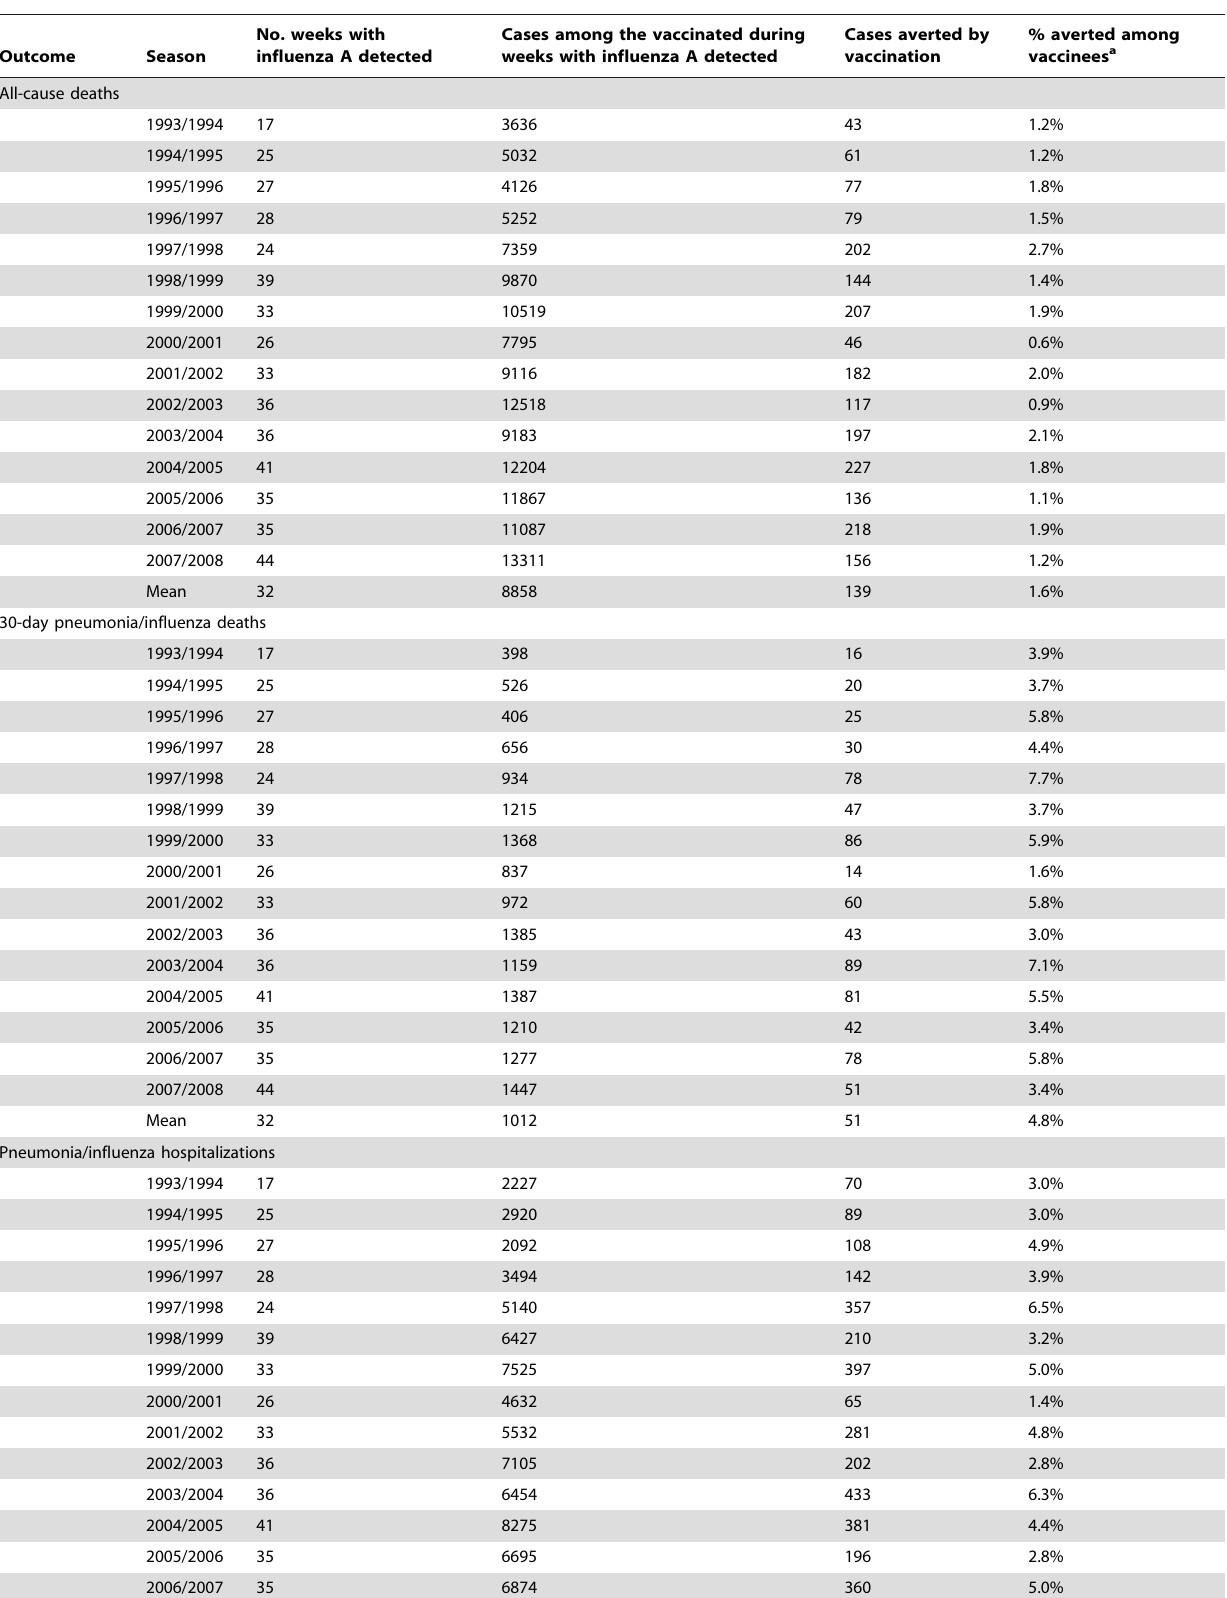
Table 3. Predicted number of cases averted by influenza vaccination, by study outcome.